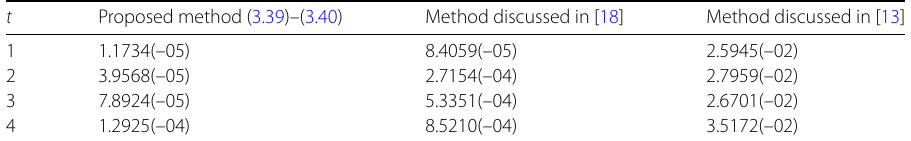
Table 3 Example 3: The global relative